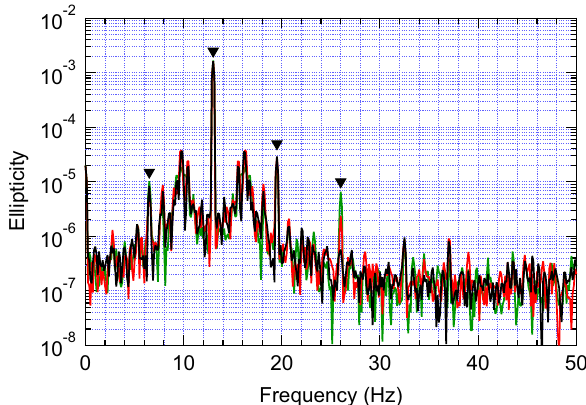
Fig. 6 Demodulated ellipticity spectra of the non-rotating 1 cm thick optical zero-wave GP oscillating laterally by ± 30 µ m at ν T = 23 Hz. Two orthogonal directions of oscillations are shown, one of them giving a minimum response at the modulation frequency